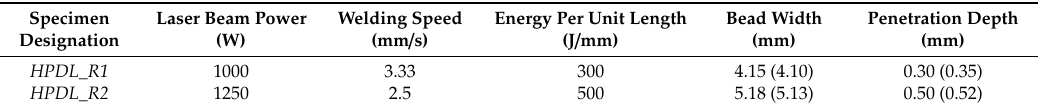
Table 7. Process parameters and comparison of geometric dimensions of beads made on 10 -mm WCL (X37CrMoV5-1) steel samples using a ROFIN DL020 high-power diode laser with values obtained from numerical analyses (values in brackets) (Figure